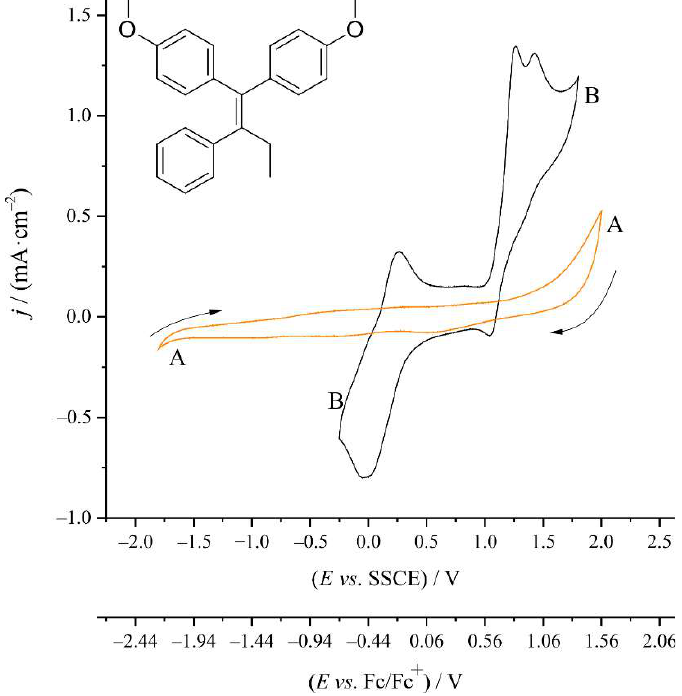
Figure 1. Cyclic voltammograms recorded at Pt (surface area A = 8.1 mm 2 ) in contact with (A) 0.1 M Bu 4 NClO 4 in MeCN (blank solution (orange curve)) (B) 0.1 M Bu 4 NClO 4 + 1 mM 42 in MeCN. Scan rate: v = 1 V/s .